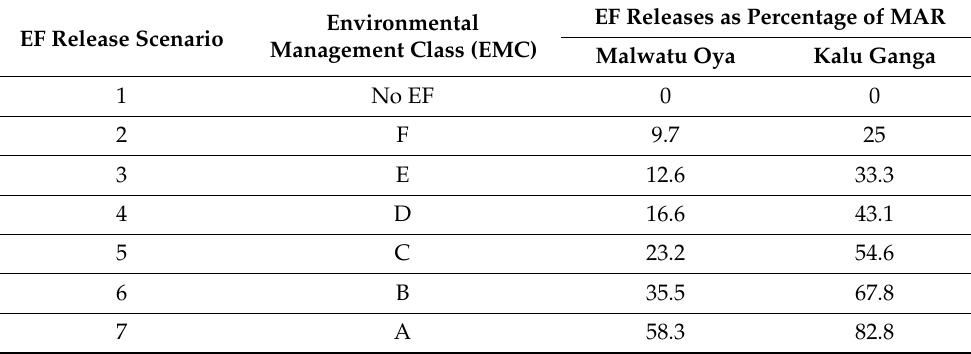
Table 2. Environmental Flow (EF) Yield requirement at the downstream end of Malwatu Oya and Kalu Ganga basins under seven EF release